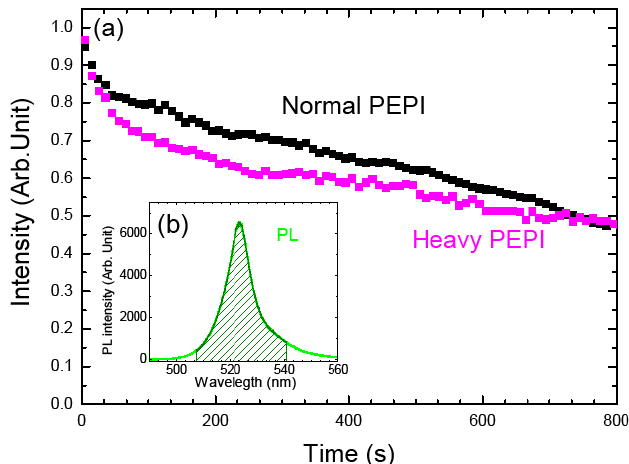
Figure 2. ( a ) Evolution of photoluminescence (PL) intensity as a function of illumination time for normal PEPI (black scatters) and “heavy” PEPI (magenta scatters). The samples are excited with the 325 nm line of a HeCd laser at 7 mW (corresponding to a fluence 0.175 W·cm −2 ) in air. The PL intensities are normalized to 1 at t = 0 s. The insert graph ( b ) is the PL spectrum of a 50 nm thick normal PEPI film measured at room temperature. The excitation source for PL measurement is the 325 nm line of a HeCd laser, with an incident power of 0.6 mW (corresponding to a fluence 0.015 W·cm −2